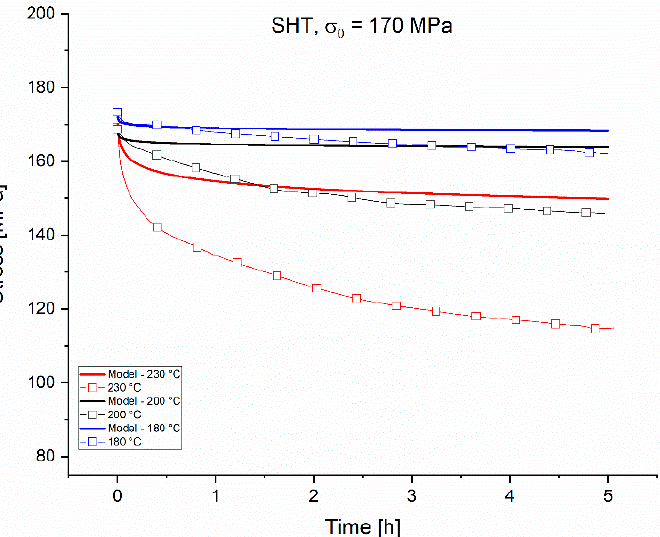
Figure 9. Comparison of experimental and simulated stress relaxation curves, tested in SHT condition at 230 °C, 200 °C, and 180 °C with a test stress of 170 MPa.